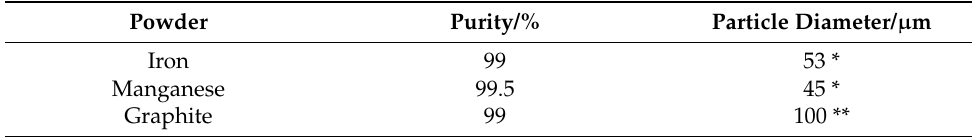
Table 1. Particle size and purity of powders in this